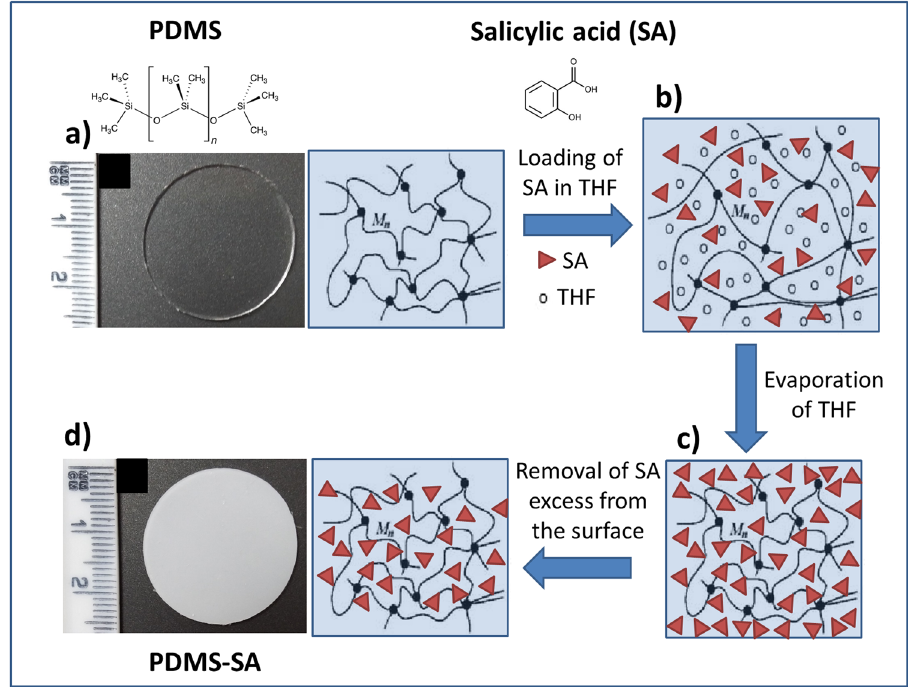
Fig. 1 Schematic representation of the loading process of salicylic acid into the polymeric matrix of PDMS. a Pristine PDMS; b swelled PDMS in the presence of a concentrated solution of SA in THF; c fast evaporation of THF leaves SA trapped within PDMS and at the surface; d removal of excess of SA from the surface leads to PDMS-SA samples. Inserted optical images show pristine PDMS and functionalised PDMS-SA